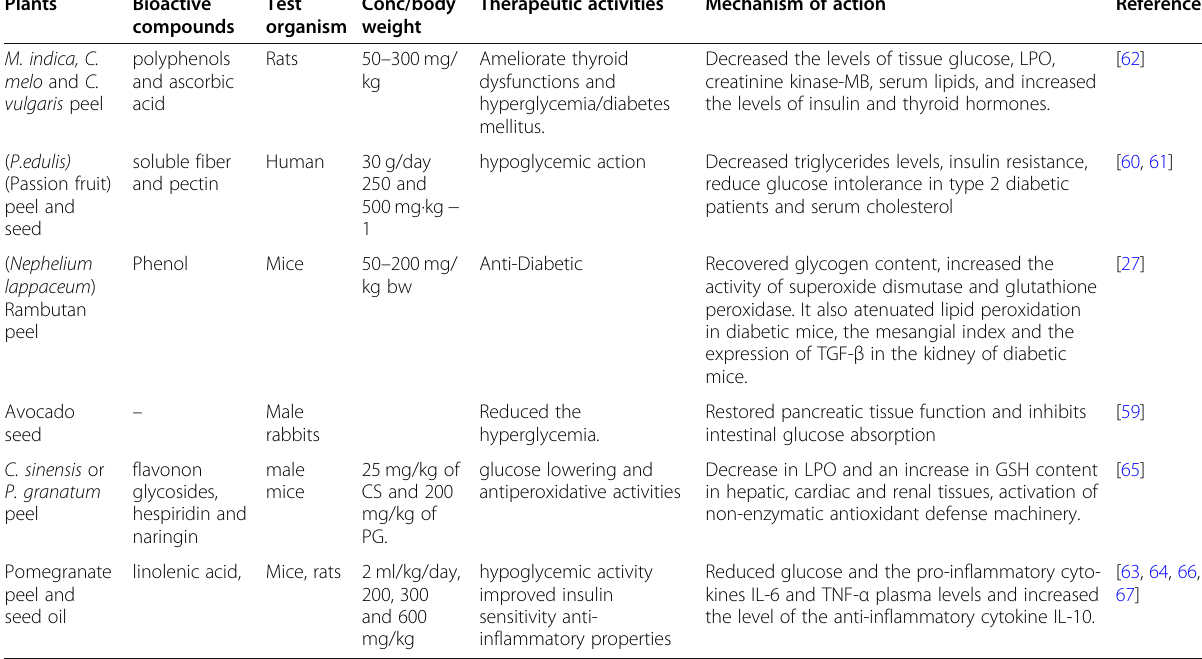
Table 3 Anti-diabetic properties of some peels and seed extracts